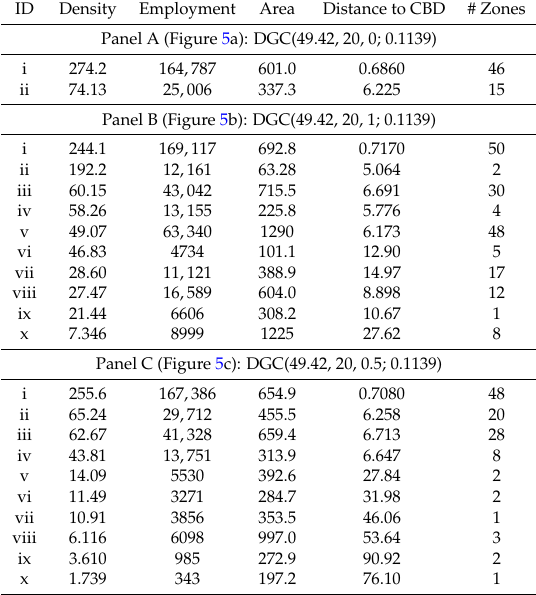
Table A3. Calgary Metropolitan Area subcenters. Density = employees per hectare; area = hectares; distance to CBD = kilometers; and # zones indicate TAZ units; IDs link subcenters to their location in respective